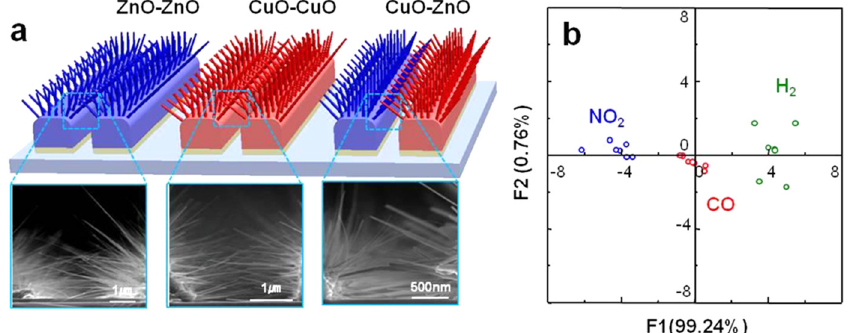
Figure 6: ( a ) Schematic representation of the crossed - nanowire junction array and corresponding SEM images. ( b ) LDA analysis classifying the points corresponding to the various gases at a 95% con fi dence level. Reprinted with permission from ref. [ 33 ]